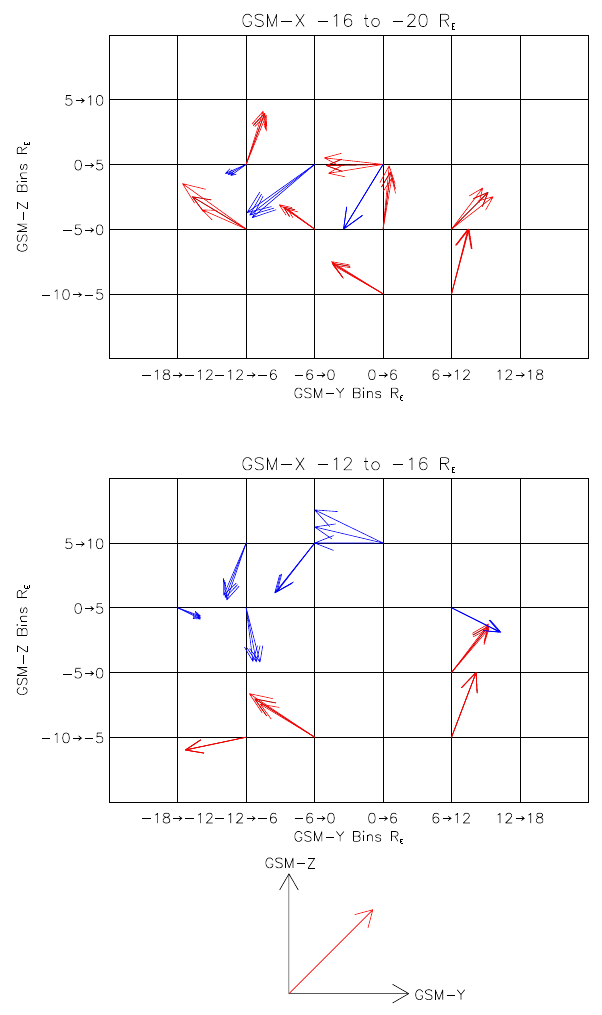
Fig. 10. The projection of the average unit normal of the boundary between the thinning plasma sheet and the lobe in the GSM–ZY direction is shown as a function of position in the GSM–ZY plane for two GSM–X bins. Plasma sheet to lobe crossings are marked in blue and red vectors for the north and south lobes, respectively. Error bars, calculated from the extreme errors on the individual vec- tors, are plotted when more than one normal vector was used for the averaging. The top panel shows that thinning in the north and south lobes tends to have a negative GSM–Y component with a variety of GSM–Z dominance. The bottom plot suggests that there is a greater variety of GSM–Y components closer to the